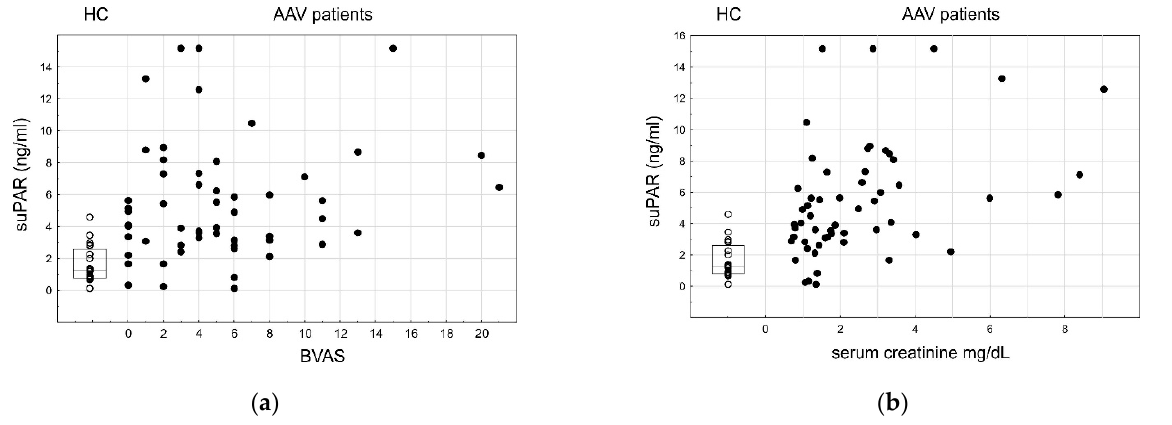
Figure 5. SuPAR plasma level and its relation to the AAV disease (suPAR HC vs. AAV, p < 0.001), its activity and the serum creatinin concentration; ○ —HC, box—IQR, line—median, ● —AAV. ( a ) Correlation of the suPAR plasma level in AAV with the BVAS, rs = 0.11, p = 0.406. ( b ) Correlation of the suPAR plasma level in AAV with serum creatinine, rs = 0.43, p < 0.001.